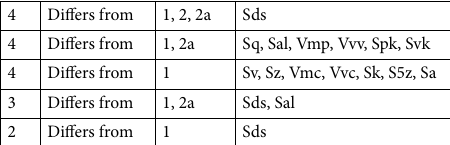
Table 2. Pairwise differences (Tukey HSD) between samples from multiple different individuals with different diets (wild, specimens 2–4) and captive (specimen 1), and samples from multiple sites within a tooth (samples 2a).